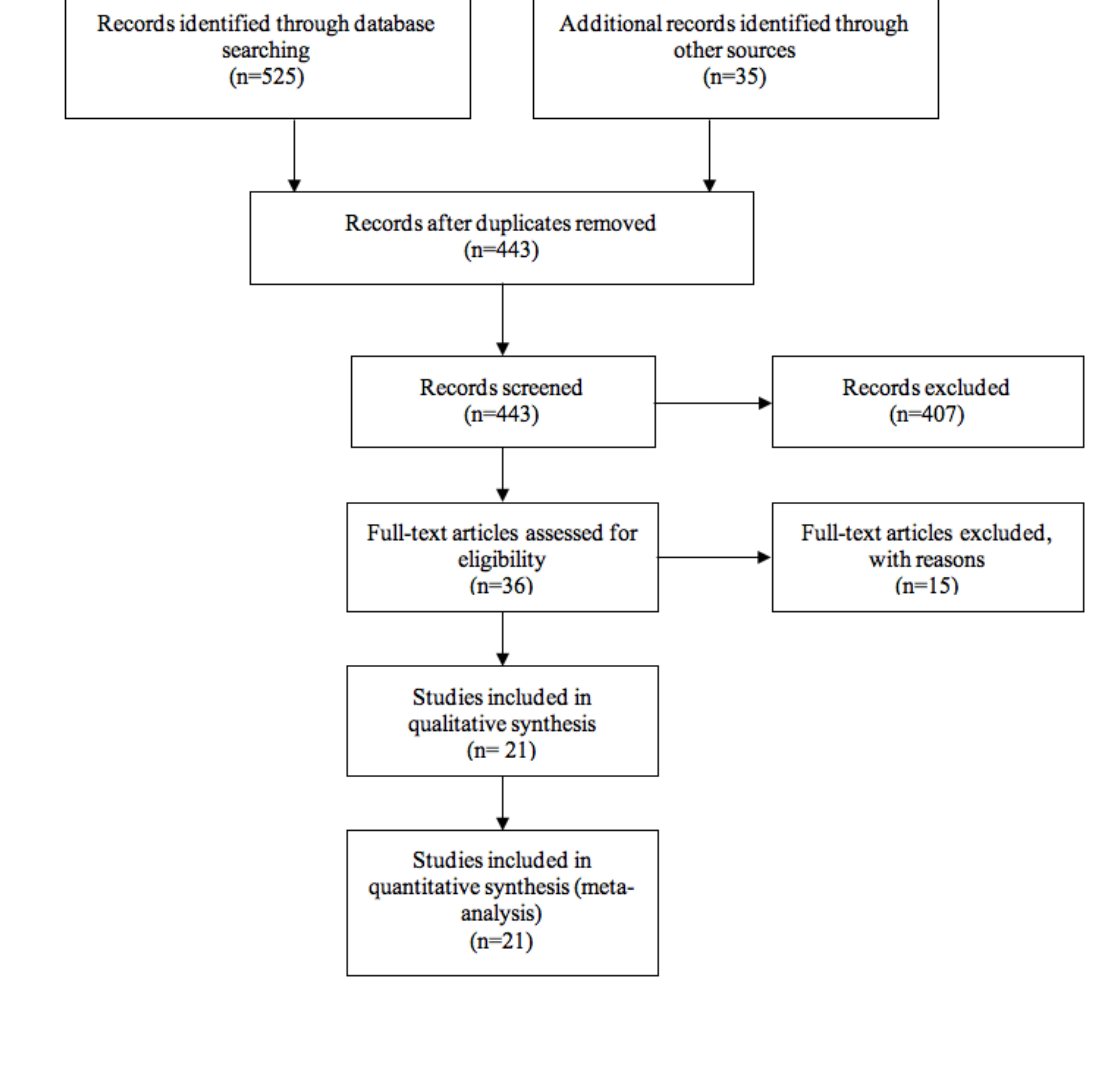
Figure 1. Preferred Reporting Items for Systematic Reviews and Meta-Analyses (PRISMA) flow